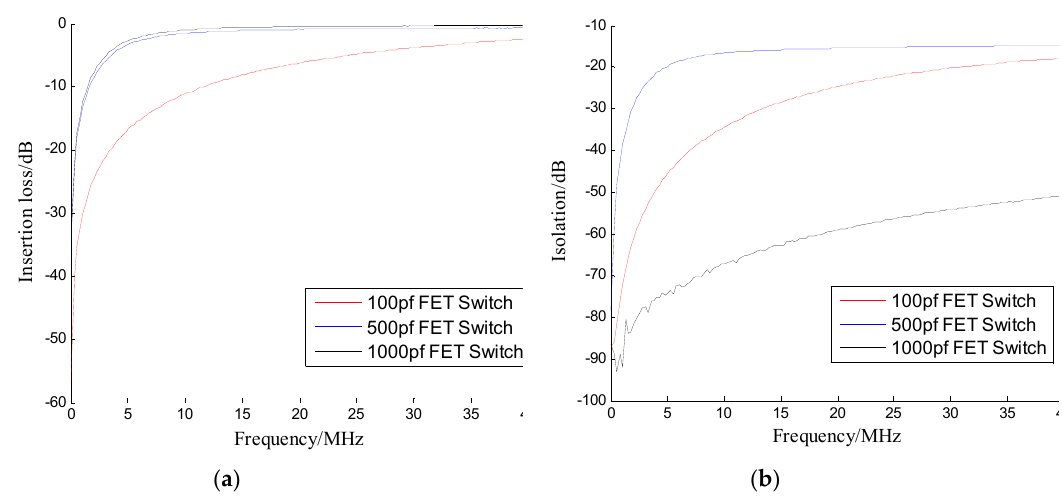
Figure 4. FET switch with different coupling capacitance values: ( a ) Insertion loss ( b ) Isolation. Table 2. Performance comparison of FET switches by 10MHz signal.